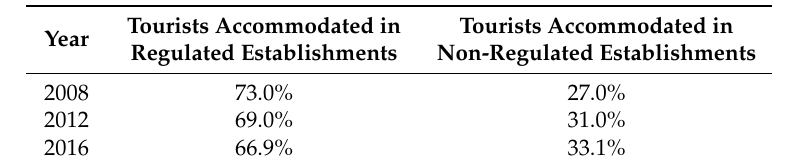
Source: Agency for Tourism of the Balearic Islands. Own elaboration. Table 2. Percentage distribution of tourist arrivals to the Balearic Islands as per type of accommodation. Years 2008, 2012 and